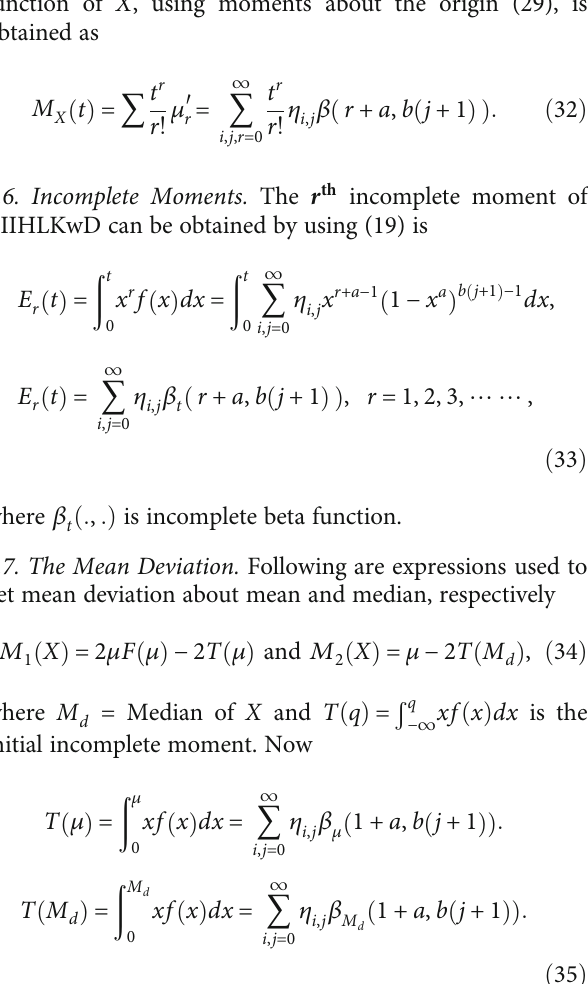
Table 1: Mean, variance, skewness ( S